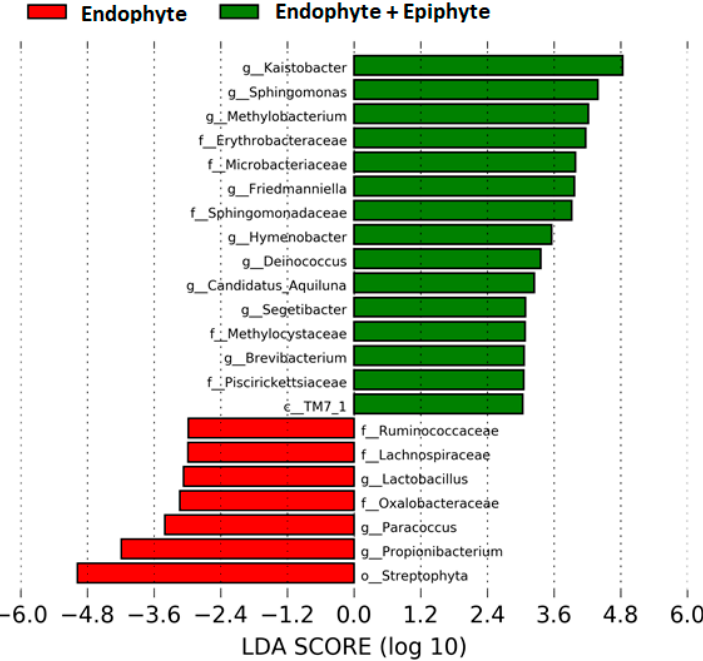
Figure 3. Differentially abundant bacterial taxa found in the plant. Linear discriminant analysis (LDA) effect size (LEfSe) comparison of horizontal bars represent the effect size for each taxon: red color indicates taxa enriched in endophyte group while green indicates taxa enriched in endophytes+epiphytes